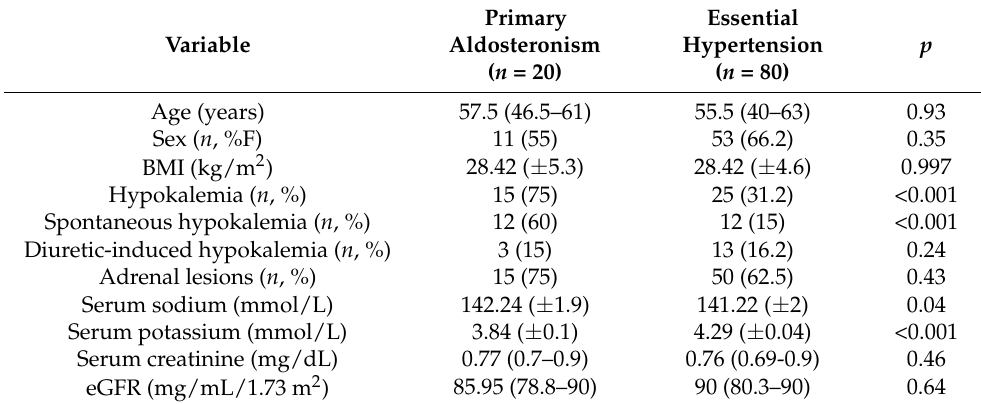
Table 2. Clinical and biochemical characteristics of the study cohort—comparison between PA and EH groups.